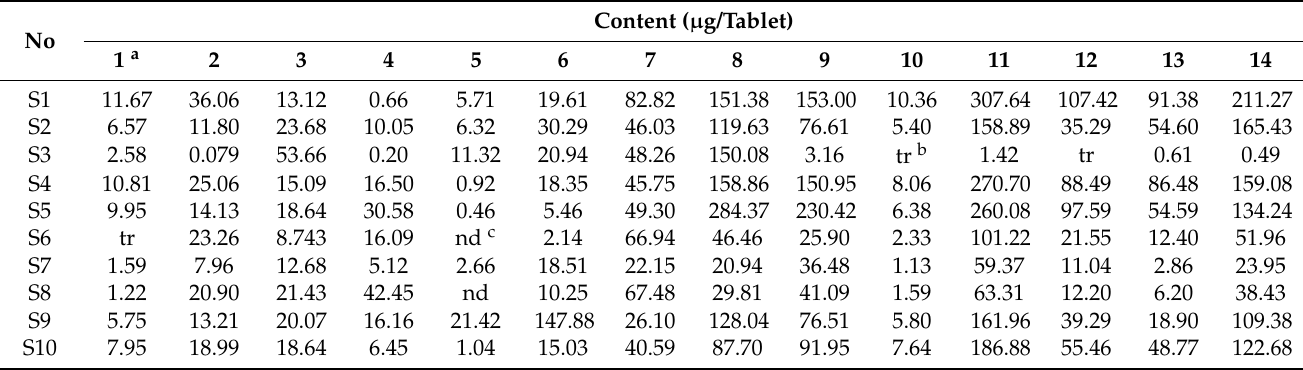
Table 5. Quantitative results for the 14 analytes in TGTs from different manufacturers.